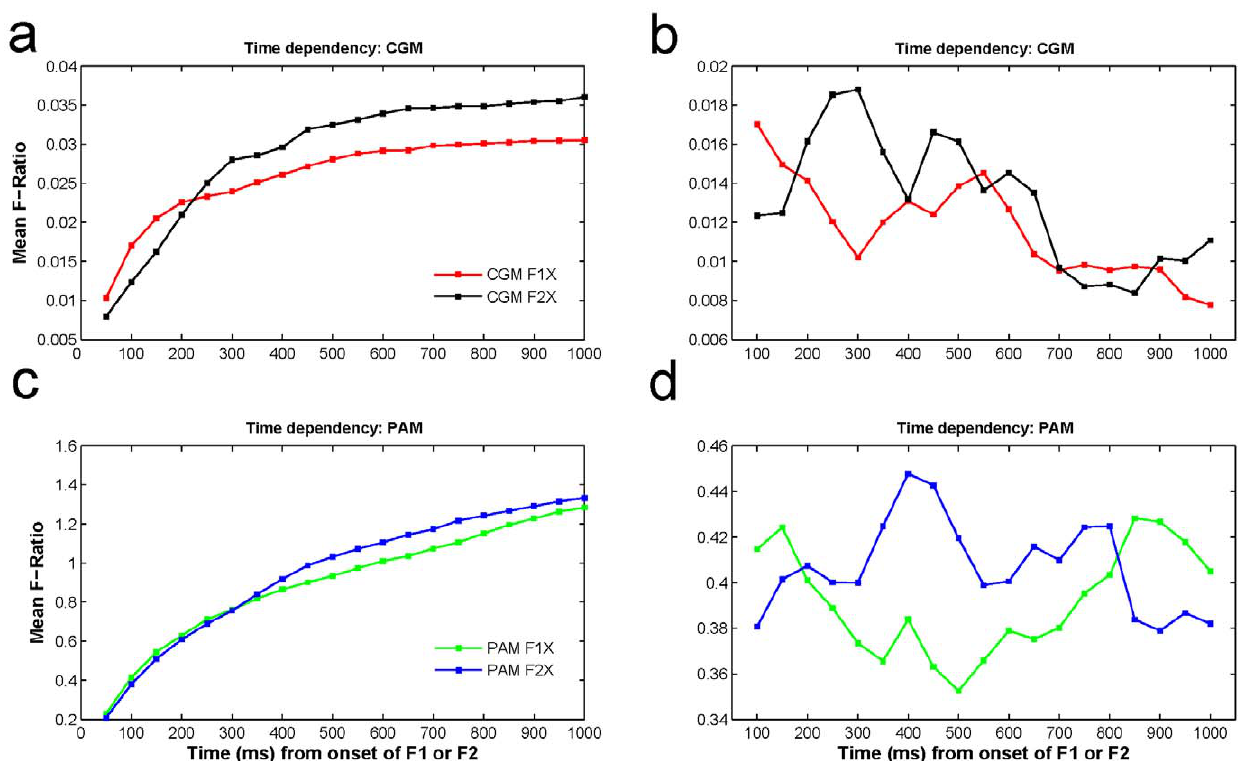
Figure 2. Time dependency of average F -ratio distribution at individual and combined level. ( a ) Temporal profiles of average F -ratio for data available (from the face onset) till that time for CGM for F1X (in red) and for F2X (in black). ( b ) Temporal profiles of average F -ratio for successive 50 ms time window for CGM for F1X (in red) and for F2X (in black). ( c ) Temporal profiles of average F -ratio for data available (from the face onset) till that time for PAM for F1X (in green) and for F2X (in blue). ( d ) Temporal profiles of average F -ratio for successive 50 ms time window for PAM for F1X (in green) and for F2X (in blue).